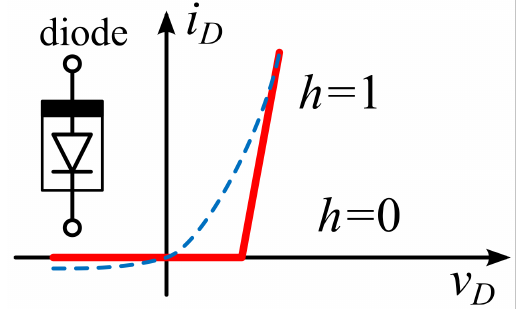
Figure 6. v - i curve of the diode.